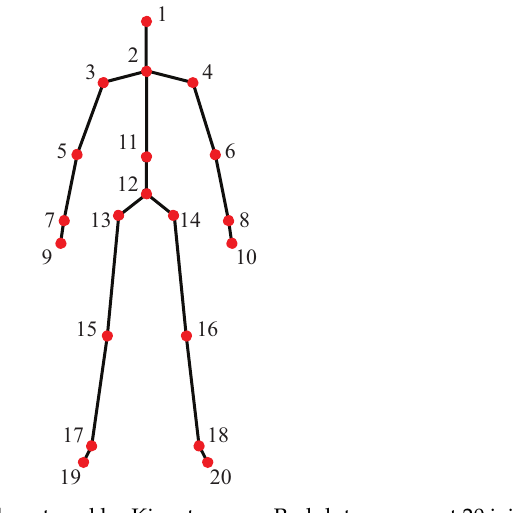
Figure 4. 3D human skeleton model captured by Kinect sensor. Red dots represent 20 joints, and black line segments represent 19 limbs. Table 1. Joint information of 3D human skeleton from Kinect sensor.